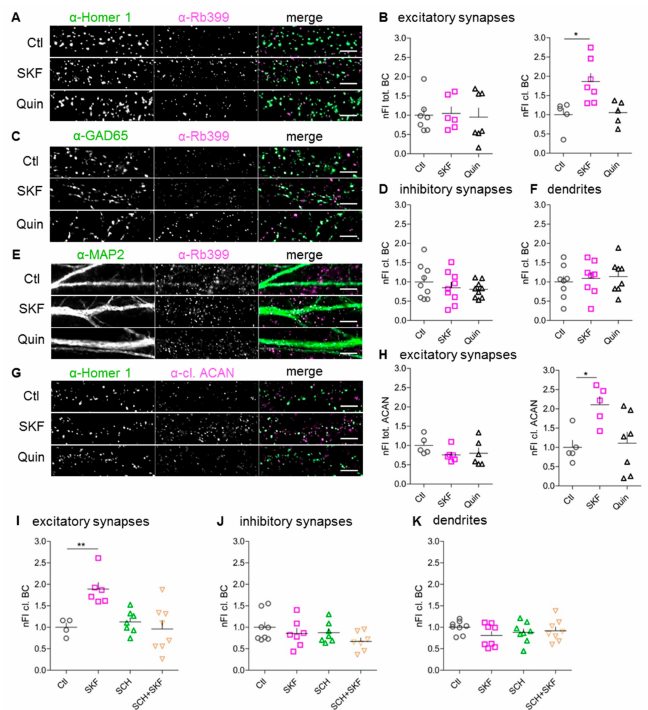
Figure 2. Modification of perisynaptic ECM at excitatory synapses is D1-like-DA-receptor-dependent. ( A , C , E ) Rat dissociated cortical neurons (DIV21) were either not treated (Ctl) or treated with SKF81297 (SKF) or quinpirole (Quin) and stained for the excitatory synaptic marker Homer 1 ( A , green), the inhibitory synaptic marker GAD65 ( C , green) or the somato-dendritic marker MAP2 ( E , green) and extracellular cleaved BC Rb399 (magenta) (scale bar: 5 µ M). ( B ) At Homer 1-positive